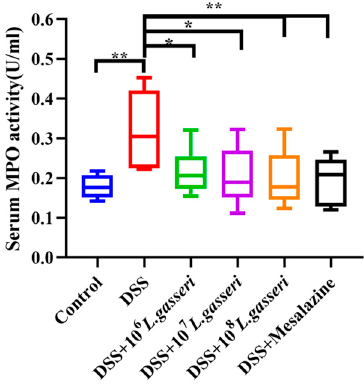
Figure 4. Changes of MPO activity in serum. * p < 0.05, ** p < 0.01 represent significant difference between groups.